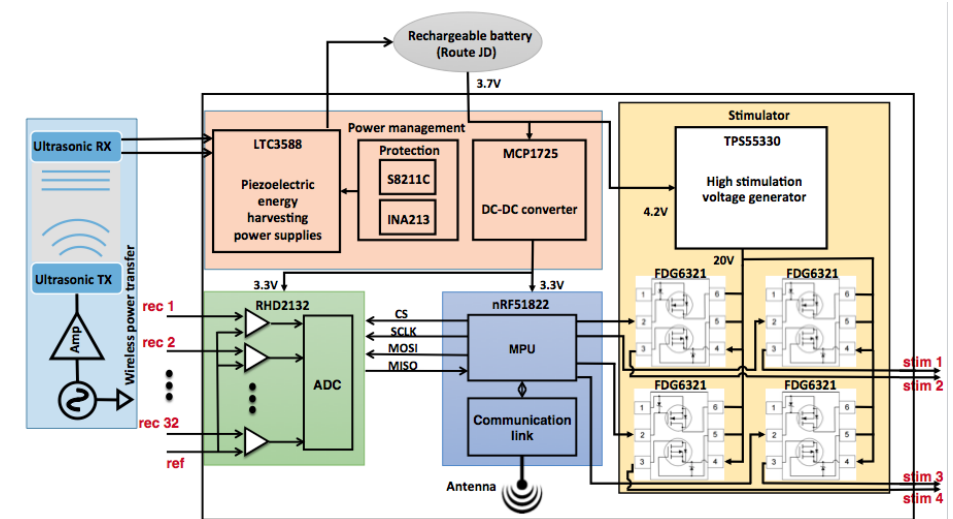
Figure 3. Implantable BBMI module circuit diagram and signal routing among the